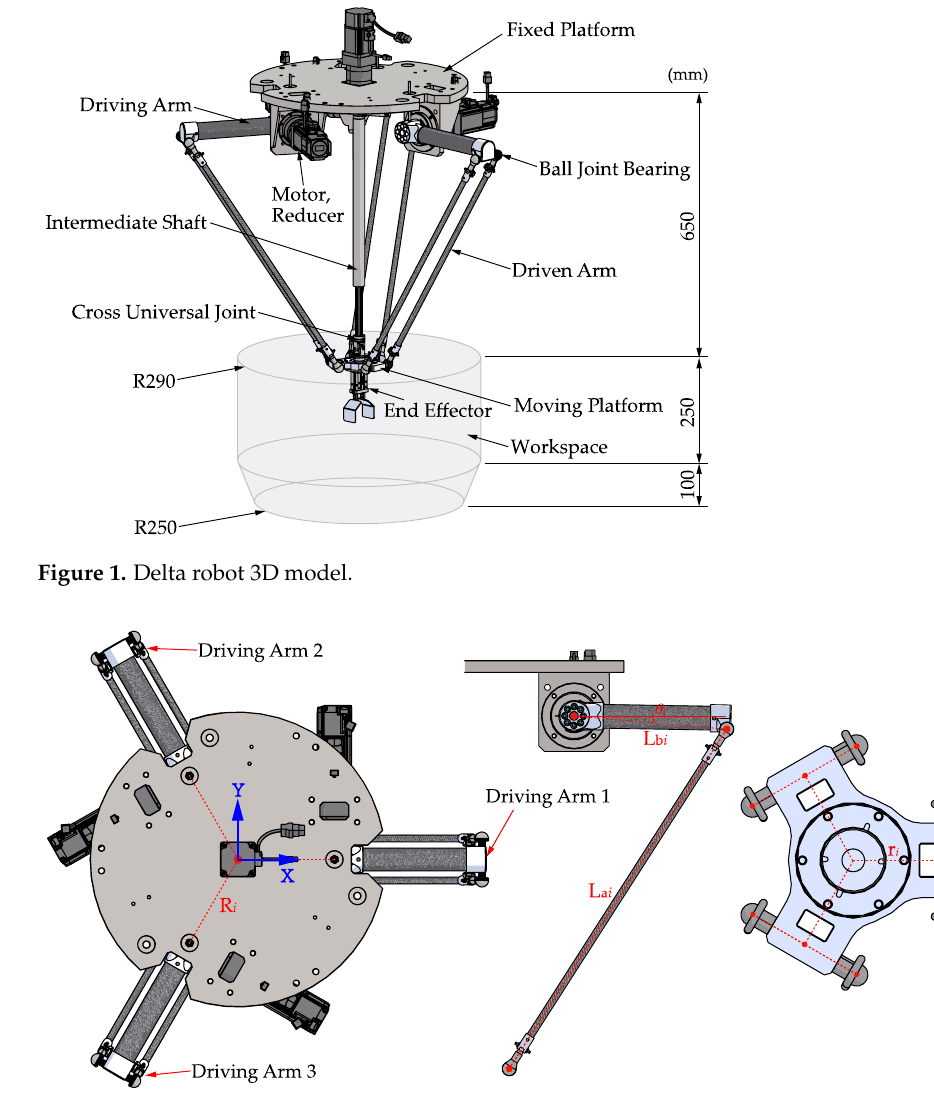
Figure 2. Notation used in the model of the Delta robot.